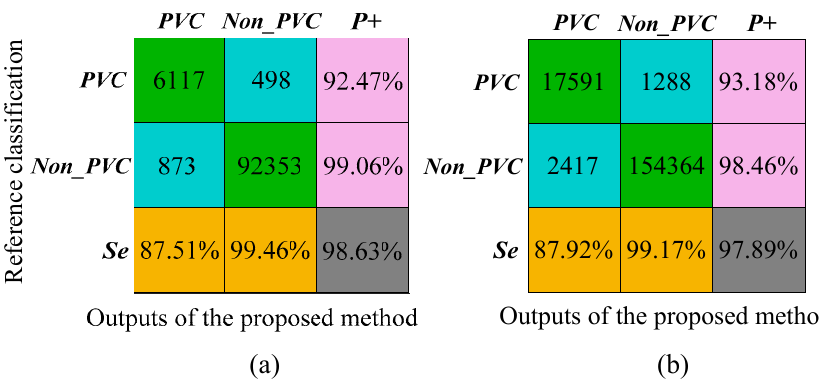
Figure 5. Results of the proposed method on the MIT-BIH-AR database and INCART database, respectively. ( a ) The evaluation indices of the proposed method on MIT-BIH-AR database; ( b ) the evaluation indices of the proposed method on INCART database.